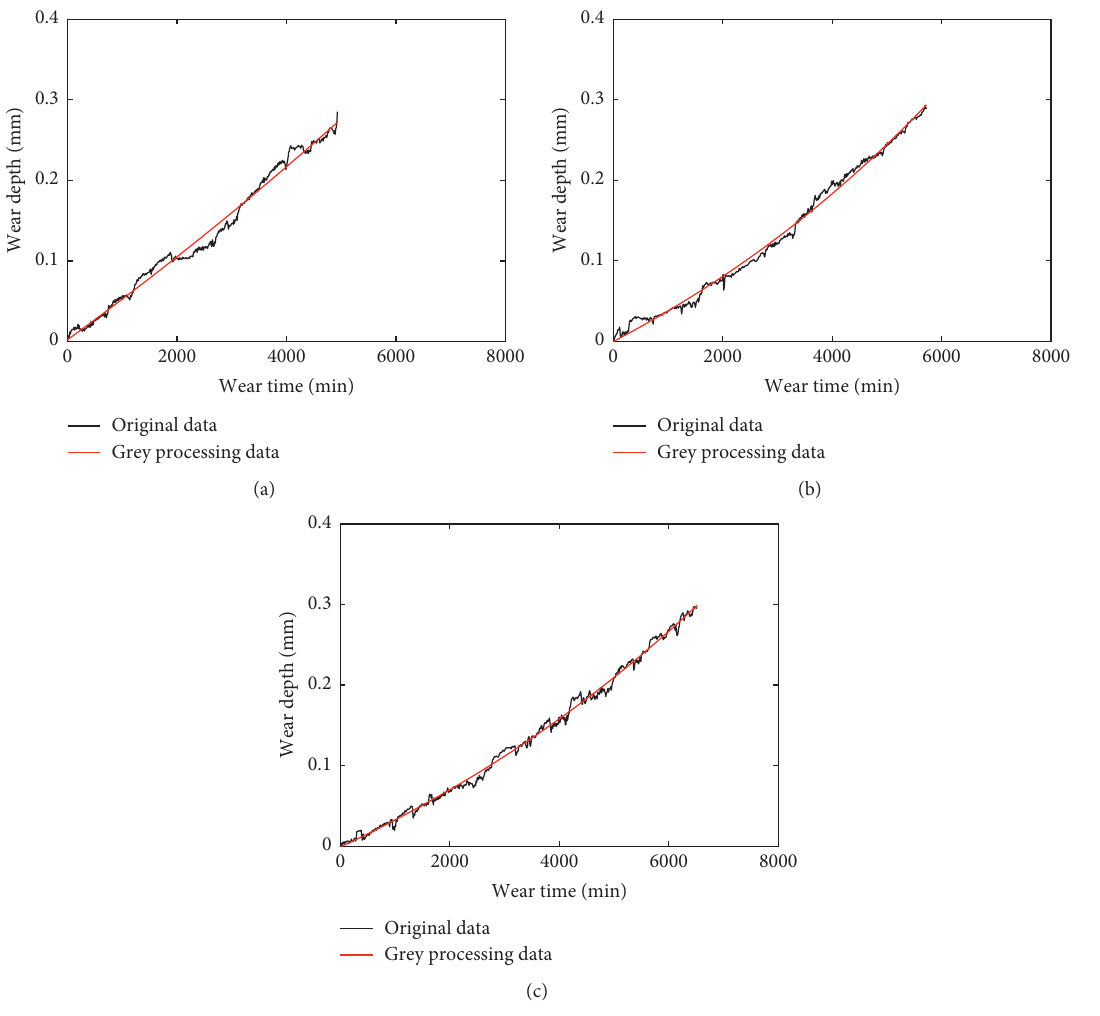
Figure 4: Prediction results of samples 1, 2, and